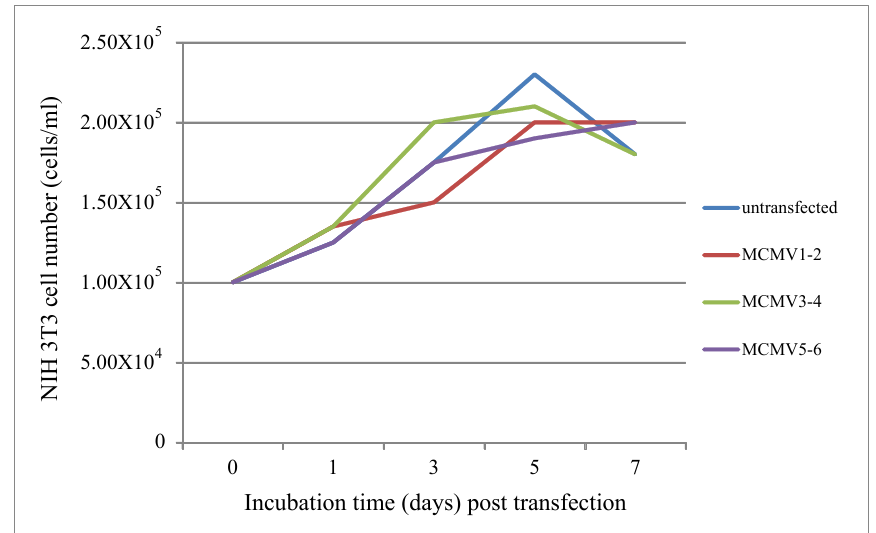
Figure 3. Host cell growth under the e ff ect of TALEN plasmids. NIH 3T3 cells (1.00 × 10 5 cells / mL) were transfected with TALEN plasmids MCMV1-2, 3-4 or 5-6, respectively. The total cells were harvested and counted 1, 3, 5 and 7 days post transfection,